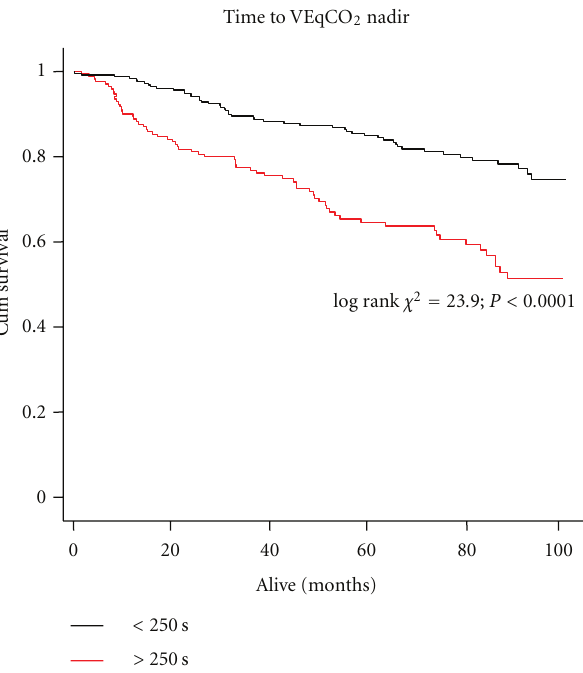
Figure 4: Kaplan-Meier survival curve showing time to VEqCO 2 nadir-data dichotomised by optimal cut-points ( < 250 s; n = 170, event free survival 61%; ≥ 250 s n = 254 patients, event free survival